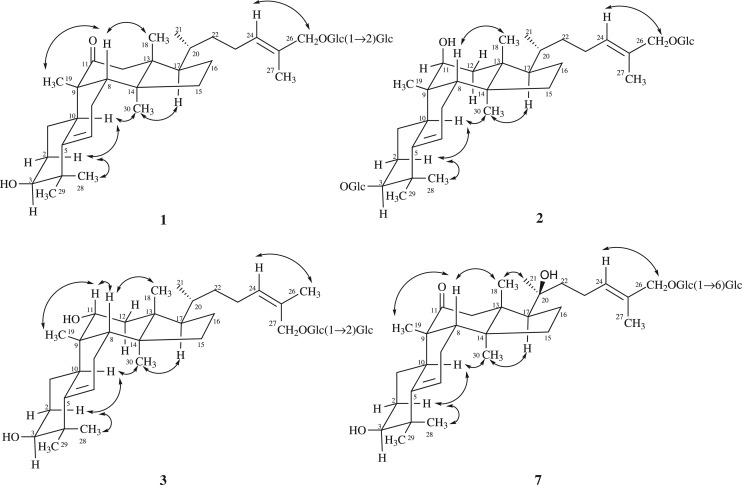
Key NOESY correlations of compounds 1–3 and 7.